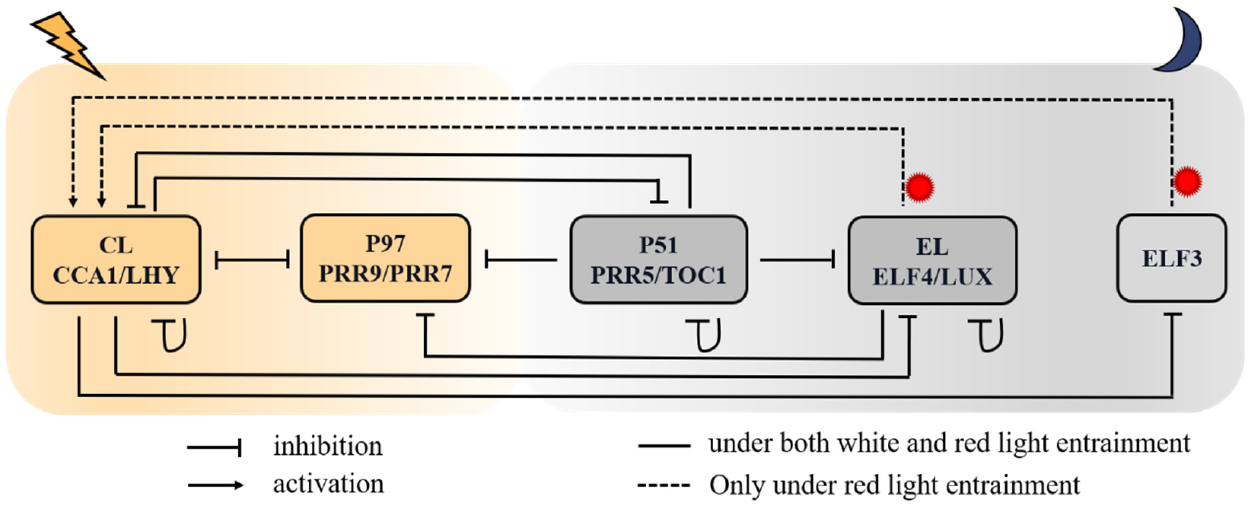
Figure 1. Schematic red-light-responsive circadian network in Arabidopsis . The genes in one box have similar expression profiles, regulators, targets, and defects in loss-of-function mutant lines. Solid lines with blunt ends indicate that genes function as repressors in the negative-feedback loops. Dotted lines and arrows indicate genes acting as activators in the regulatory network. The lightning and moon symbols represent light and darkness, respectively. CL ( CCA1 / LHY ) and P97 ( PRR9 / PRR7 ) are morning-peaking genes, and the rest are afternoon-peaking or night-peaking genes. The dotted lines indicate regulatory relationships only under red light.